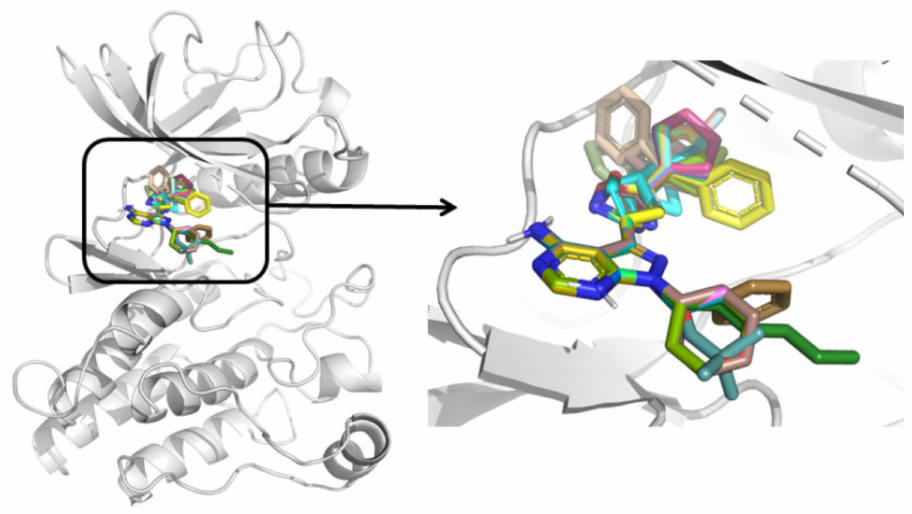
Figure 5. Alignment of the dataset compounds inside the active site of RET kinase (the arrow indicates the enlarged view of the dataset alignment inside the active site of RET kinase).